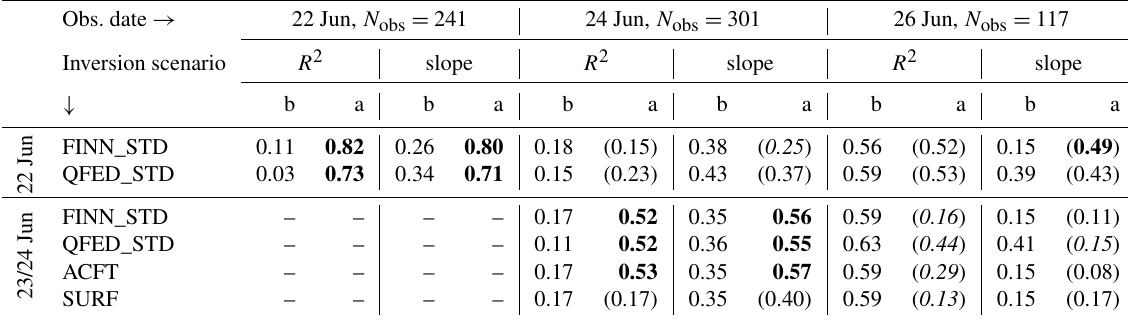
Figure 5. Prior and posterior model versus 22 June ARCTAS-CARB observations for the 22 June inversion. The left two plots are for FINN_STD and QFED_STD. The plot on the right shows the progression of the slope and R 2 from the prior, “0”, to the posterior, “a”, for similar linear regressions in all scenarios. Table 2. Aircraft observation linear regression characteristics for the prior (background, b) and posterior (analysis, a). Obs. date